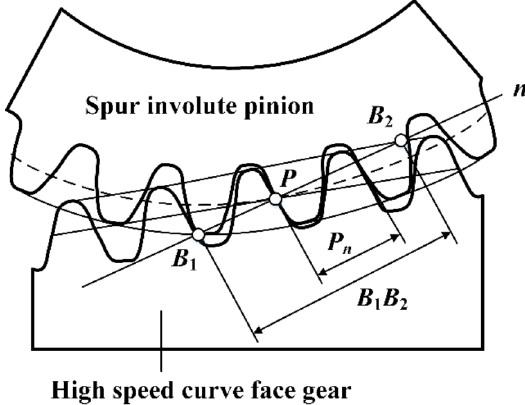
Fig. 6. Contact ratio of high speed curve face gear pair.